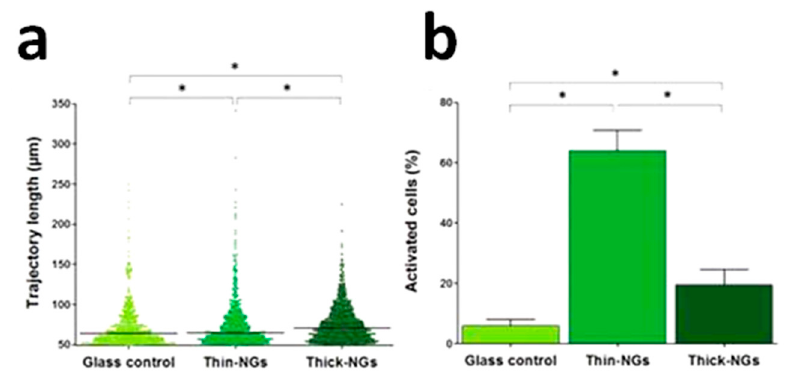
Figure 8. Effect of the thin- and thick-nanogenerators (NGs) on macrophages and Saos-2 cell activity. ( a ) Macrophage motility quantified as trajectory lengths. Distances shorter than 50 μ m were considered in situ motions; ( b ) Quantification of Saos-2 cells undergoing changes in Ca 2+ concentration (activated cells). Asterisks (*) above the columns indicate significant differences between data sets, according to Kruskal–Wallis test and χ 2 test. Modified with permission from reference [93]. Copyright (2017) John Wiley & Sons, Inc.